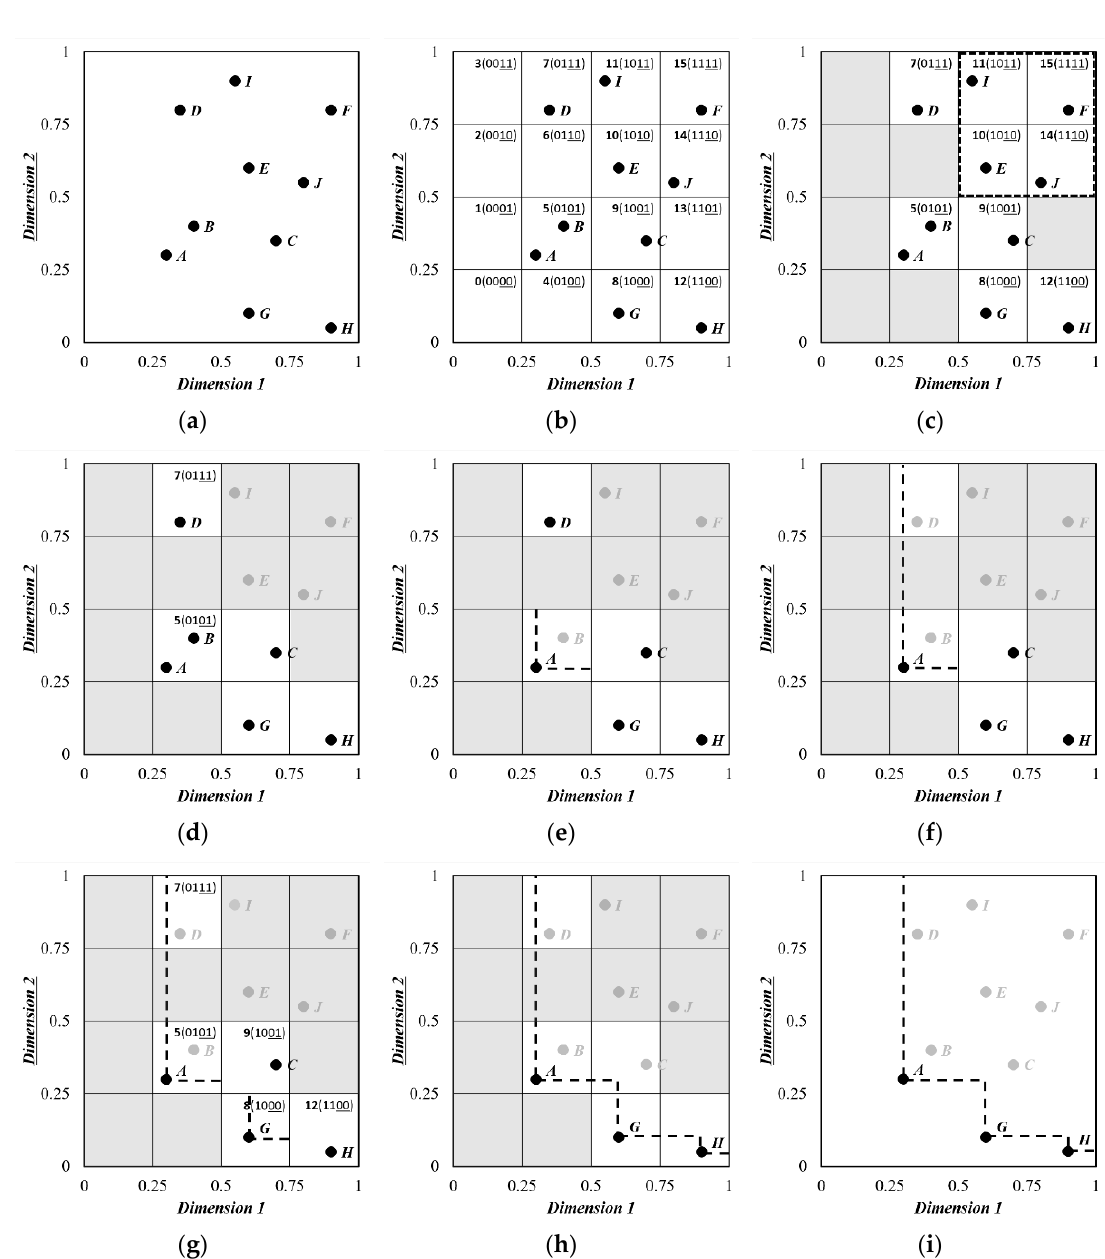
Figure 3. An example of skyline query processing based on HI-Sky. ( a ) 2-D data space;( b ) result of HashGrid; ( c ) data space pruning; ( d ) data pace pruning (cont.); ( e ) skyline computation; ( f ) skyline computation (cont.); ( g ) skyline computation (cont.); ( h ) skyline computation (cont.); ( i ) result of skyline